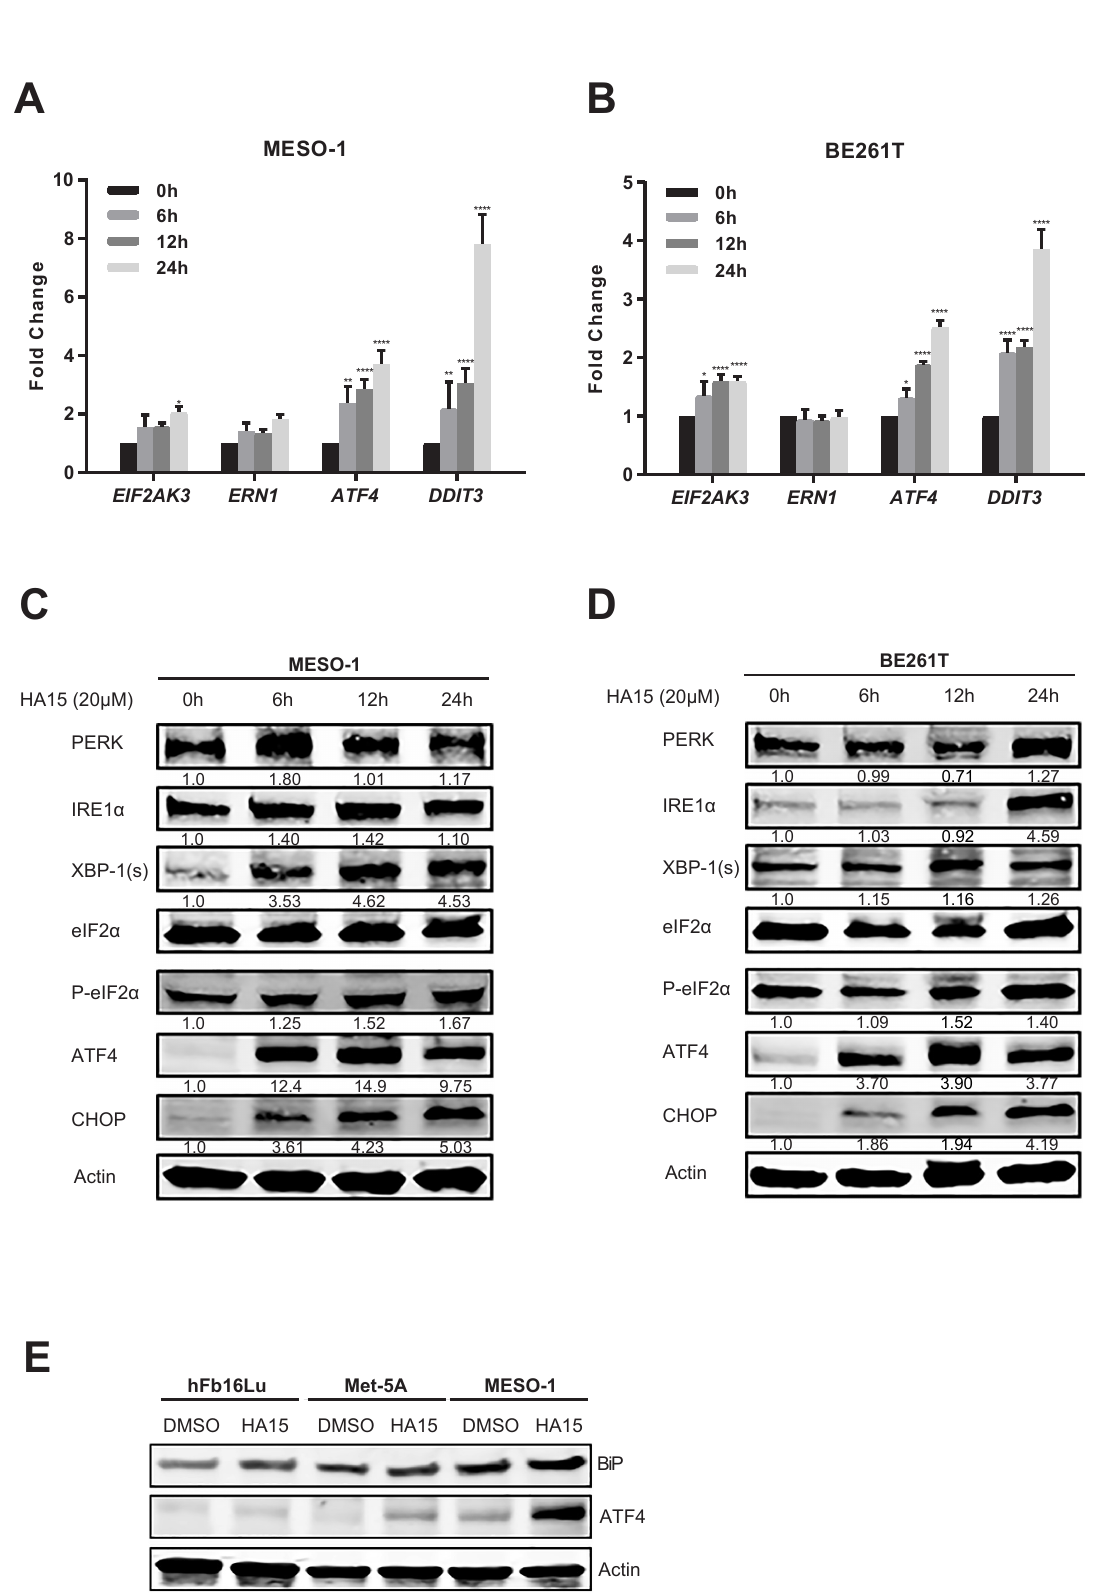
Figure 3. HA15-induced ER stress activates malfunctional UPR in MPM cells. ( A , B ) qRT-PCR of MESO-1 and BE261T cells after treatment with HA15 (10 uM) for the indicated time points. Data are presented as mean ± s.d. ( n = 3). * p < 0.05, ** p < 0.01, and **** p < 0.0001 by two-way ANOVA